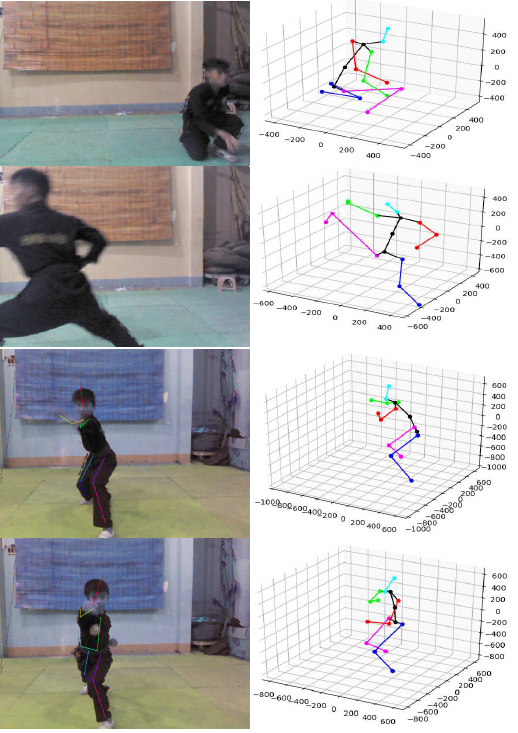
Fig. 16: The results of 3-D human pose estimation, when some parts are